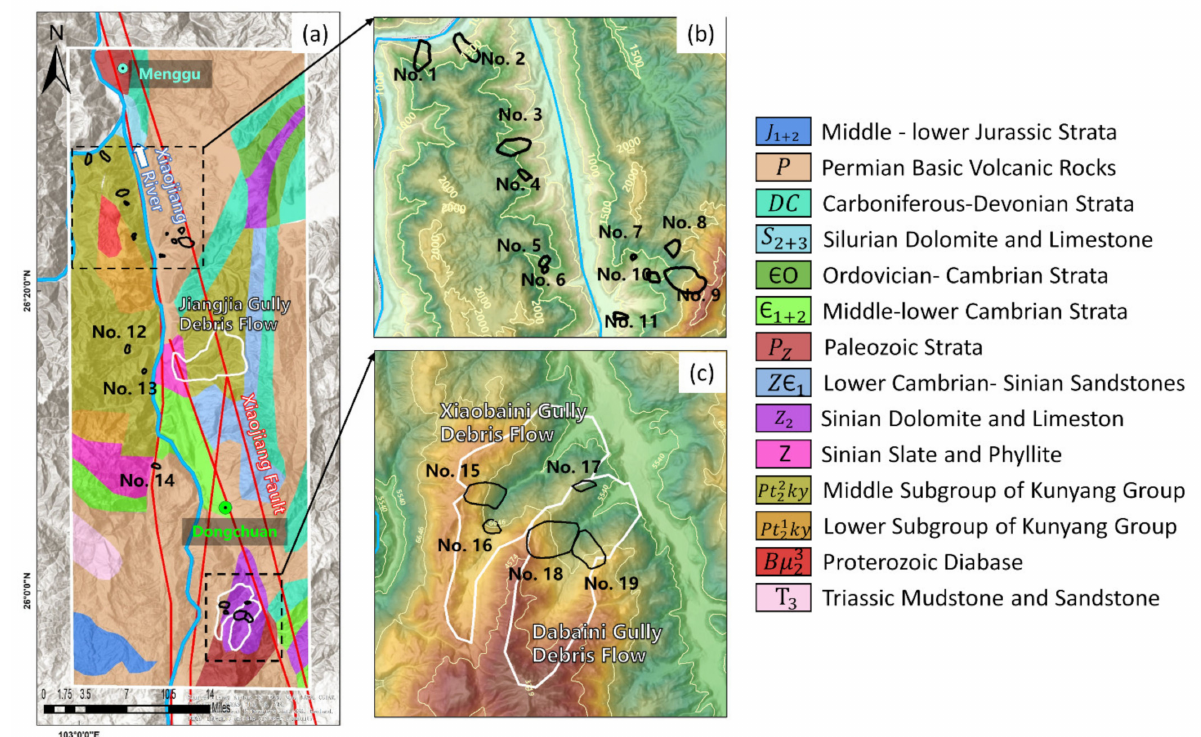
Figure 2. ( a ) Geological setting of the study area (modified from data sharing by Geographic Data Sharing Infrastructure, College of Urban and Environmental Science, Peking University. White curves map the major historical debris flows. Black curves map the recorded landslides (data support from China Aero Geophysical Survey & Remote Sensing Center for Land and Resources (AGRS)). ( b ) and ( c ) are enlarged views of two local regions, with SRTM DEM as the base